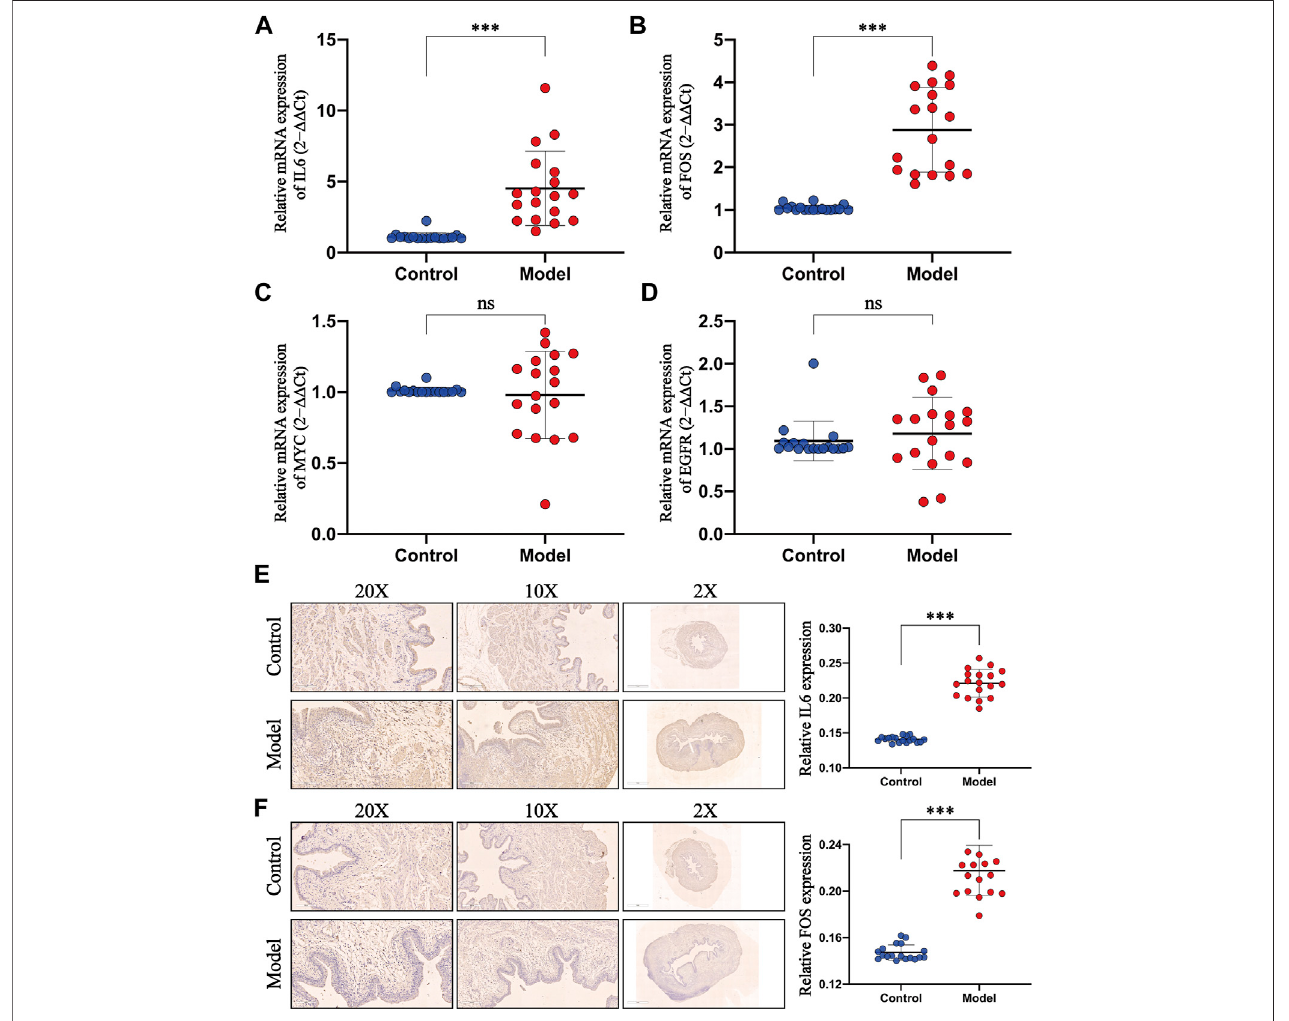
FIGURE 9 | Evaluation of the expression level of pivotal targets in the E. coli – induced UTI model. (A – D) Levels of IL6, FOS, MYC, and EGFR mRNA were detected by qPCR, and GAPDH was used as an internal control to normalize the data. (E – F) Expressions of IL6 and FOS of rat bladders in the control and model groups were evaluated by IHC ( × 200 magni fi cation, scale bar:100 μ m; × 100 magni fi cation, scale bar:200 μ m; × 2 magni fi cation, scale bar:1 mm) and the corresponding semiquantitative data. All presented values were expressed as means ± S. D, n (cid:1) 18. *** p < 0.001 compared with the control group, ns: not statistically signi fi cant (Student ’ s